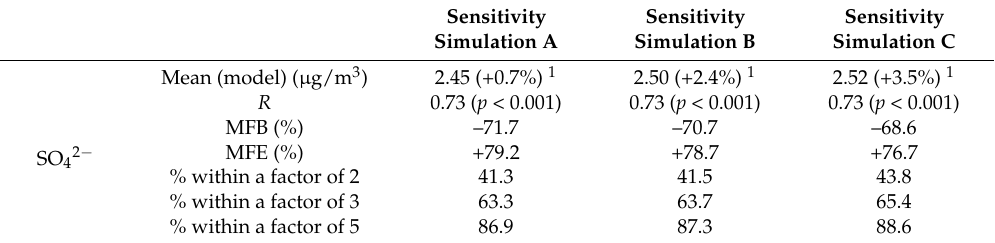
Figure 6. Changes in ( a ) SO 42 − concentration and ( b ) production from aqueous-phase oxidation averaged over ( i ) spring, ( ii ) summer, ( iii ) autumn, and ( iv ) winter. Model results from sensitivity simulation A are compared with the base-case simulation. Table 4. Statistical analysis of model performance on SO 42 − during winter through three sensitivity